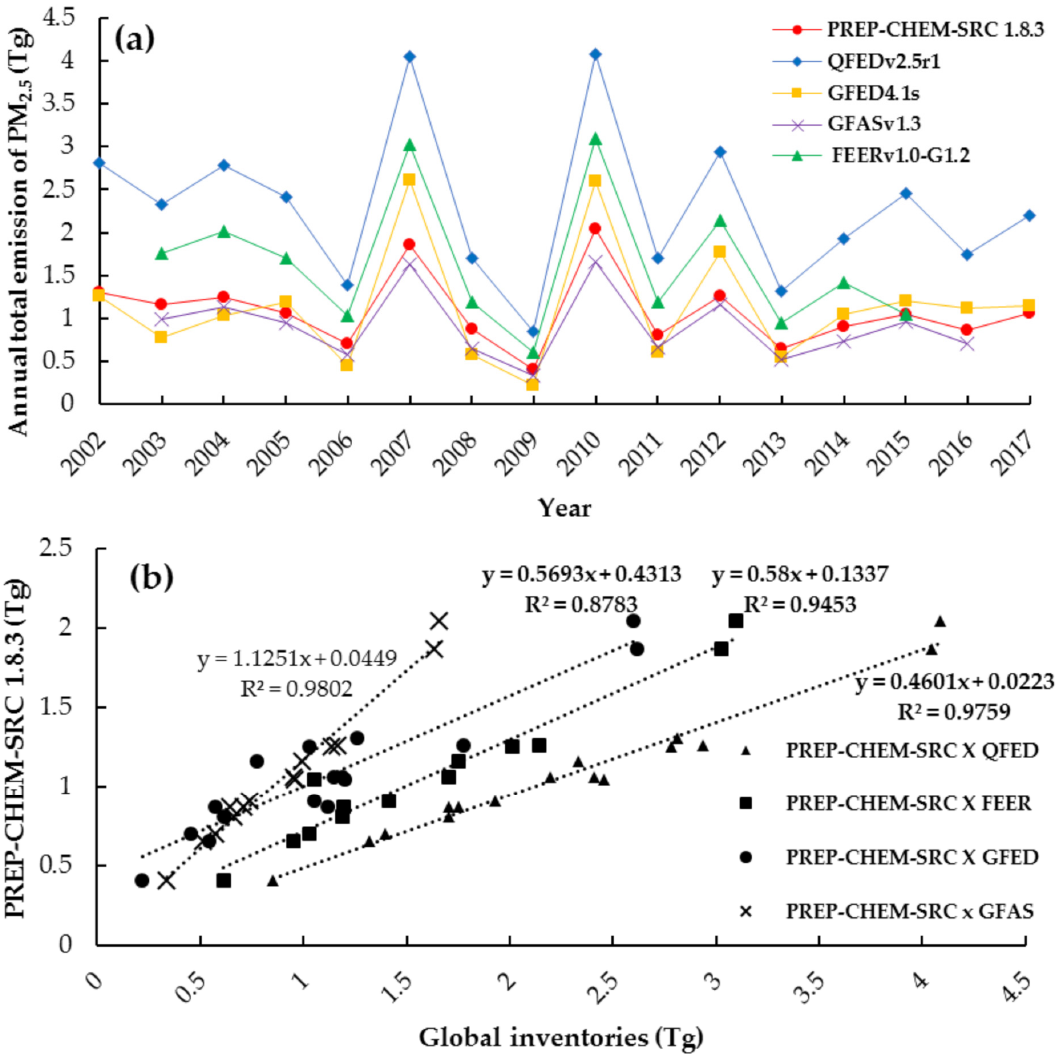
Figure 4. ( a ) Annual total emission of PM 2.5 associated with fires in the Cerrado biome estimated from PREP-CHEM-SRC 1.8.3 (2002–2017 period), GFASv1.3 (2003–2016 period), QFEDv2.5r1 (2002–2017 period), FEERv1.0-G1.2 (2003-September / 2015 period), and GFED4.1s (2002–2017 period; 2017 estimates are preliminary) and ( b ) Scatterplot between PREP-CHEM-SRC 1.8.3 annual estimates and the